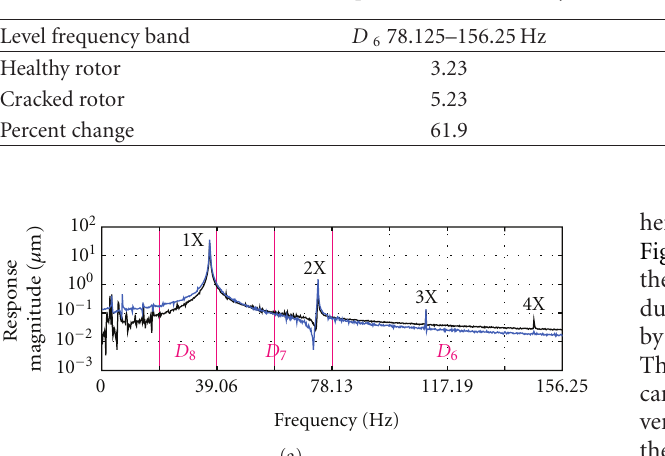
Table 3: Comparison of rms values ( μ m) of healthy and cracked rotors with excitation.